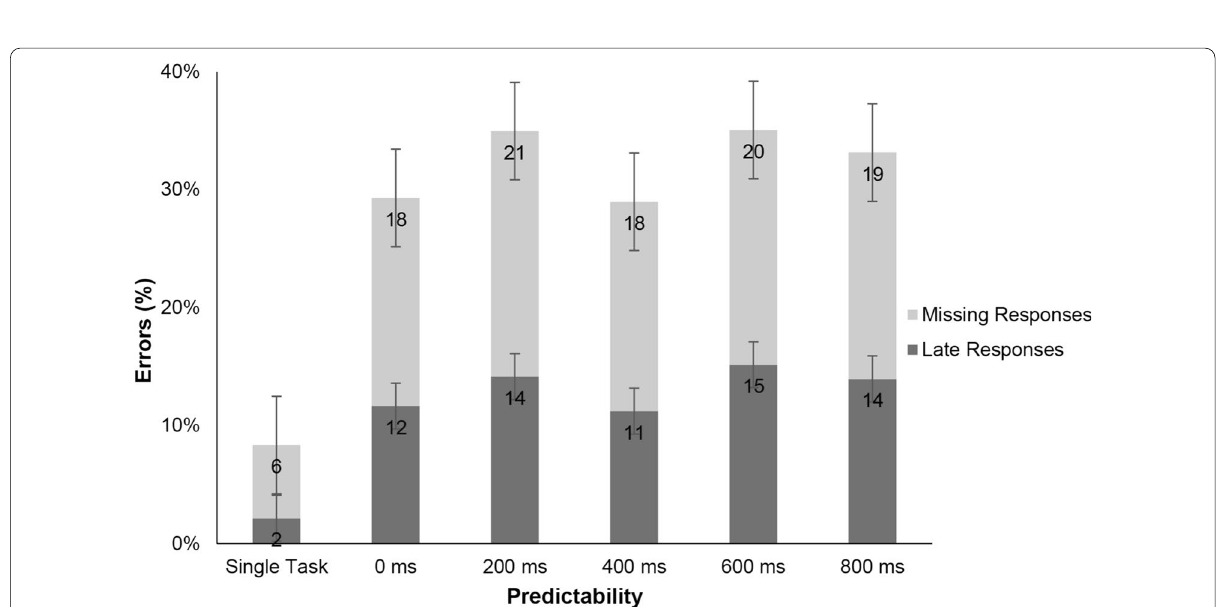
Fig. 5 Errors in Experiment 1 were either late responses given later than 800 ms after sound onset (in dark grey) or missing responses that were not given at all (in light grey). Error bars show the standard